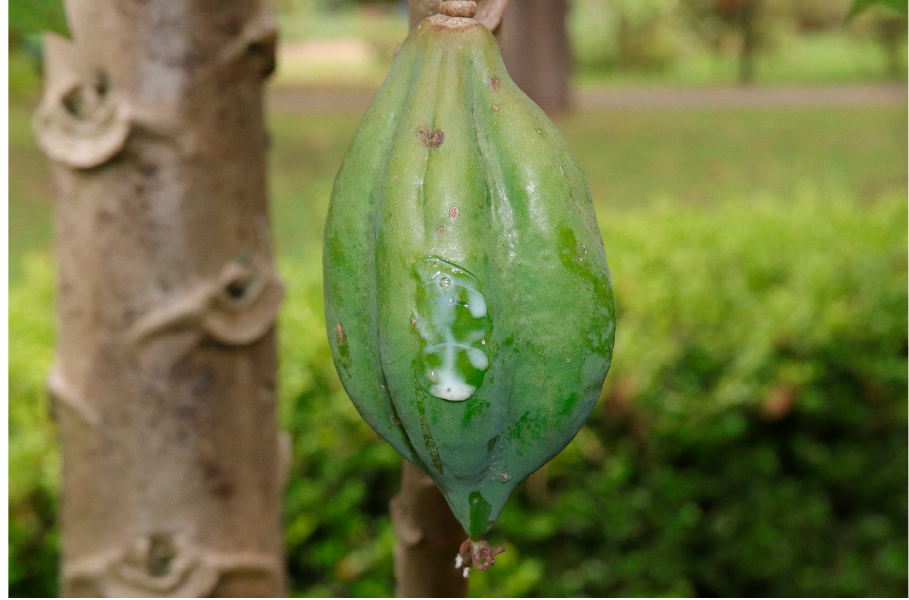
Figure 2. Photo of Vasconcellea pubescens A.DC (copyright held by Royal Botanical Gardens, Kew). A bark extract showing wound-healing potential is Pycnogenol ® , which is the regis- tered name for an extract from a French maritime pine, Pinus pinaster Aiton. Pycnogenol ®